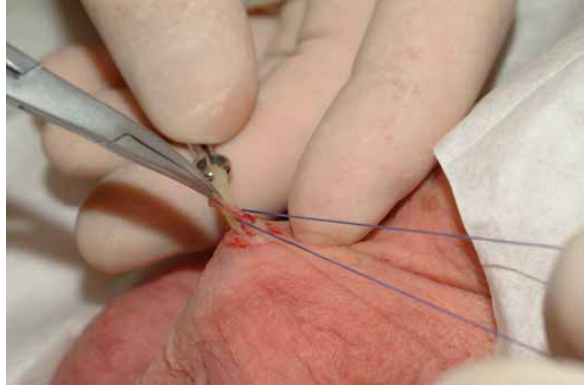
Figure 8 - Ligating the fascia over the prostatic stump (1).